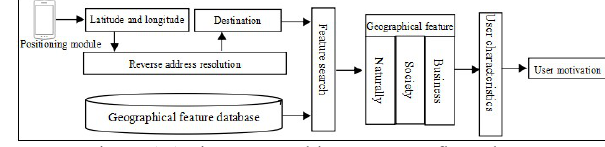
Figure 1 Active geographic awareness flow chart The core content of active geographic awareness is to build a geographic feature database. This paper constructs a geographic feature database from three levels of business, nature and